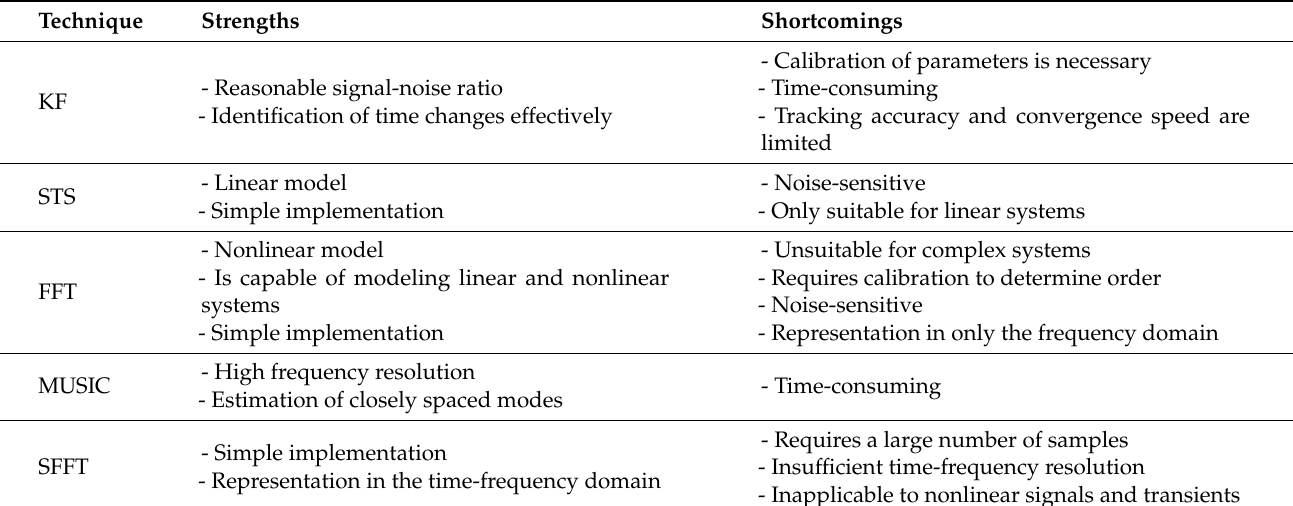
Table 27. Signal processing methods used for